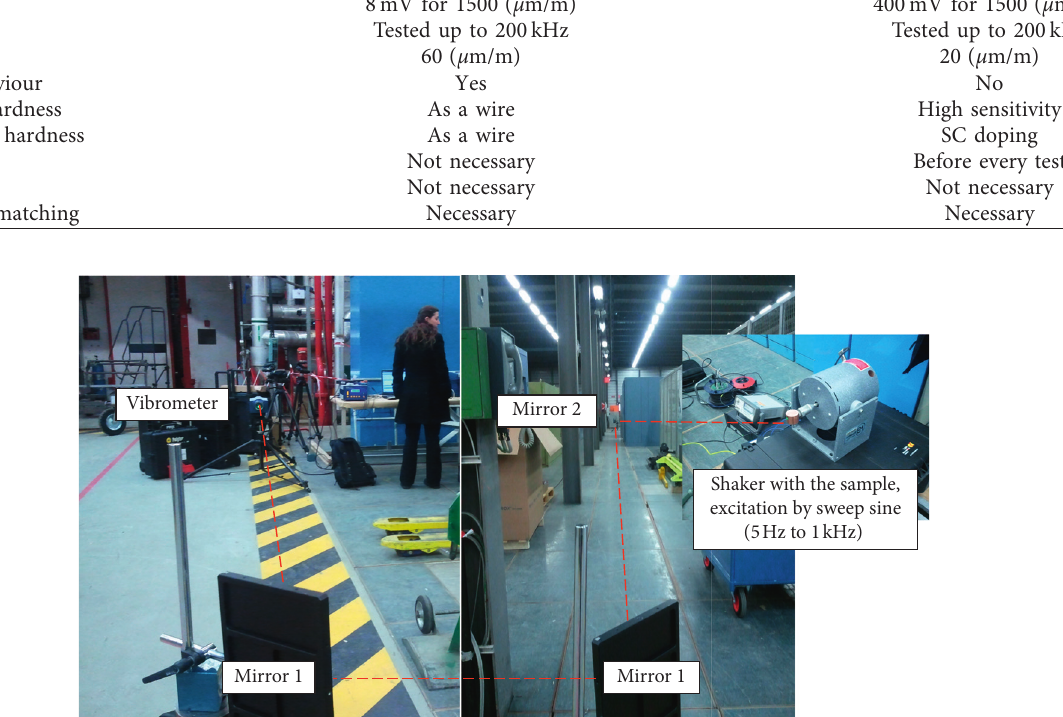
Figure 14: Qualification test for the vibrometer RSV-150 from Polytec ® . Mirrors 1 and 2 were provided by Polytec ® with a size of, respectively, 420 × 297mm 2 and 297 × 210mm 2 .